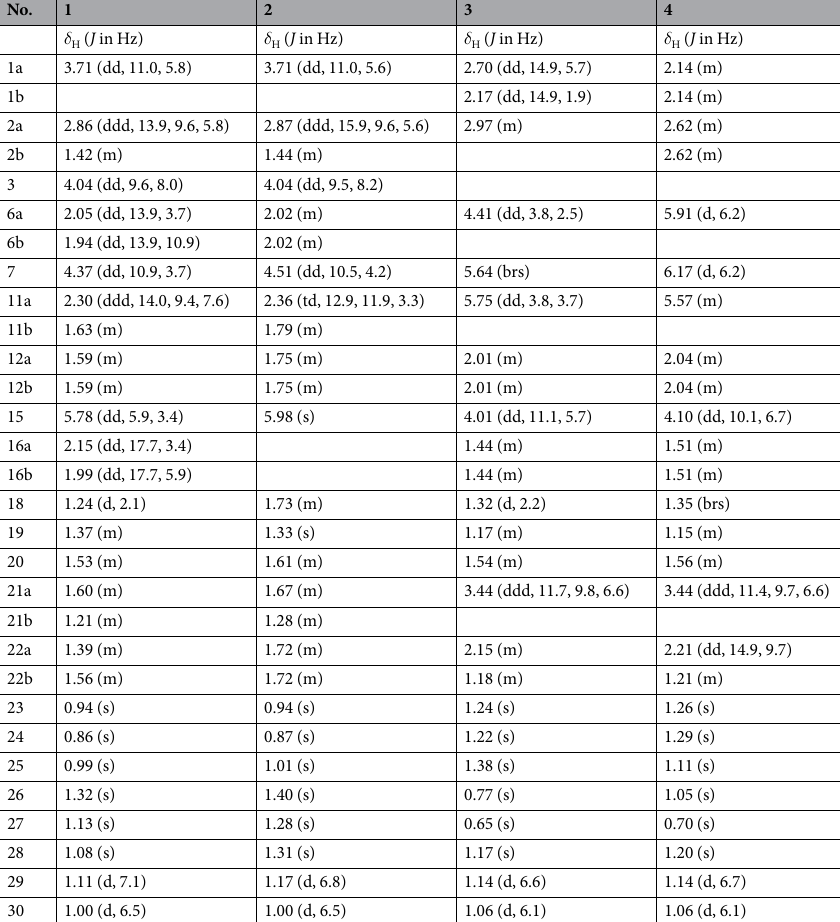
Table 2. 1 H NMR (600 MHz) data of compounds 1 – 4 in CD 3